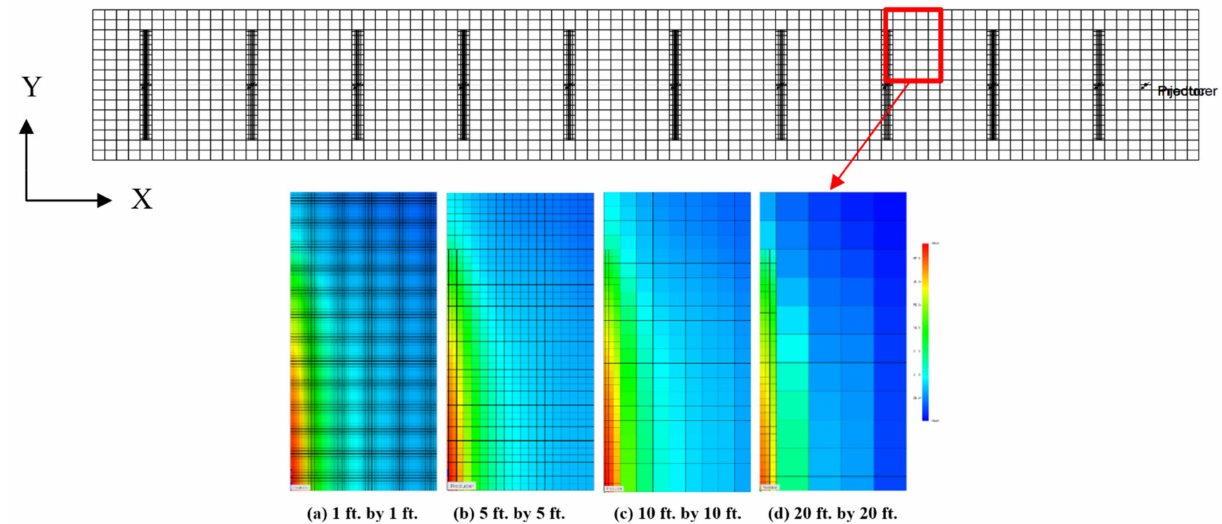
Figure 1. (Top) The reservoir model with one horizontal well and (bottom) the element of symmetry representing the reservoir model discretized by ( a ) 1 × 1 ft 2 , ( b ) 5 × 5 ft 2 , ( c ) 10 × 10 ft 2 , and ( d ) 20 × 20 ft 2 grid block sizes. Blue and red colors represent minimum and maximum solvent (injection gas) concentrations in oil, respectively. Table 1. Reservoir and natural fracture (NF) properties based on Eagle Ford shale.